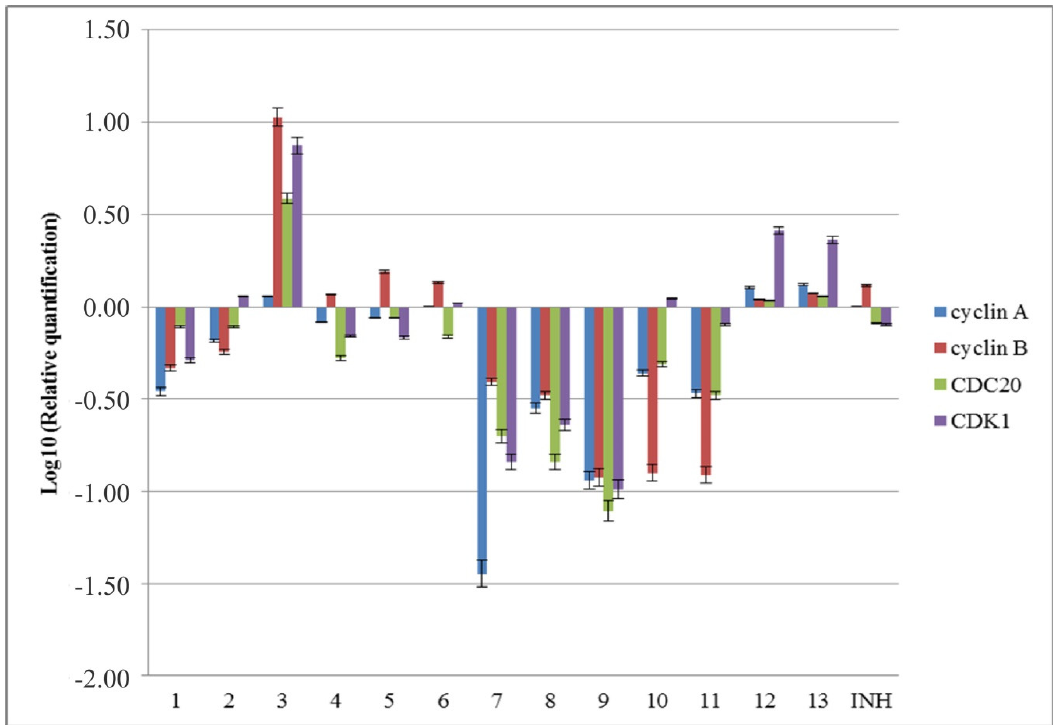
Figure 7. The influence of the new isoniazid derivatives 1 – 13 on the expression of cyclin A , cyclin B , CDK1 , and CDC20 genes in the eukaryotic cells.